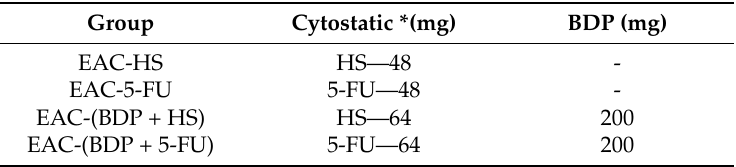
Table 3. Drugs Compositions.